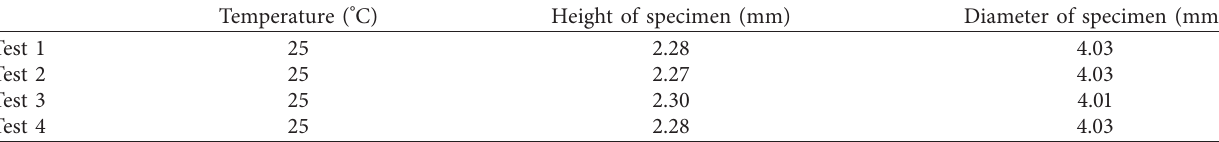
Table 4: Experimental conditions of the dynamic compression of TRIP800 steel spot welds at room temperature. Temperature ( ° C) Height of specimen (mm) Diameter of specimen (mm) Test 5 25 2.58 4.02 25 2.59